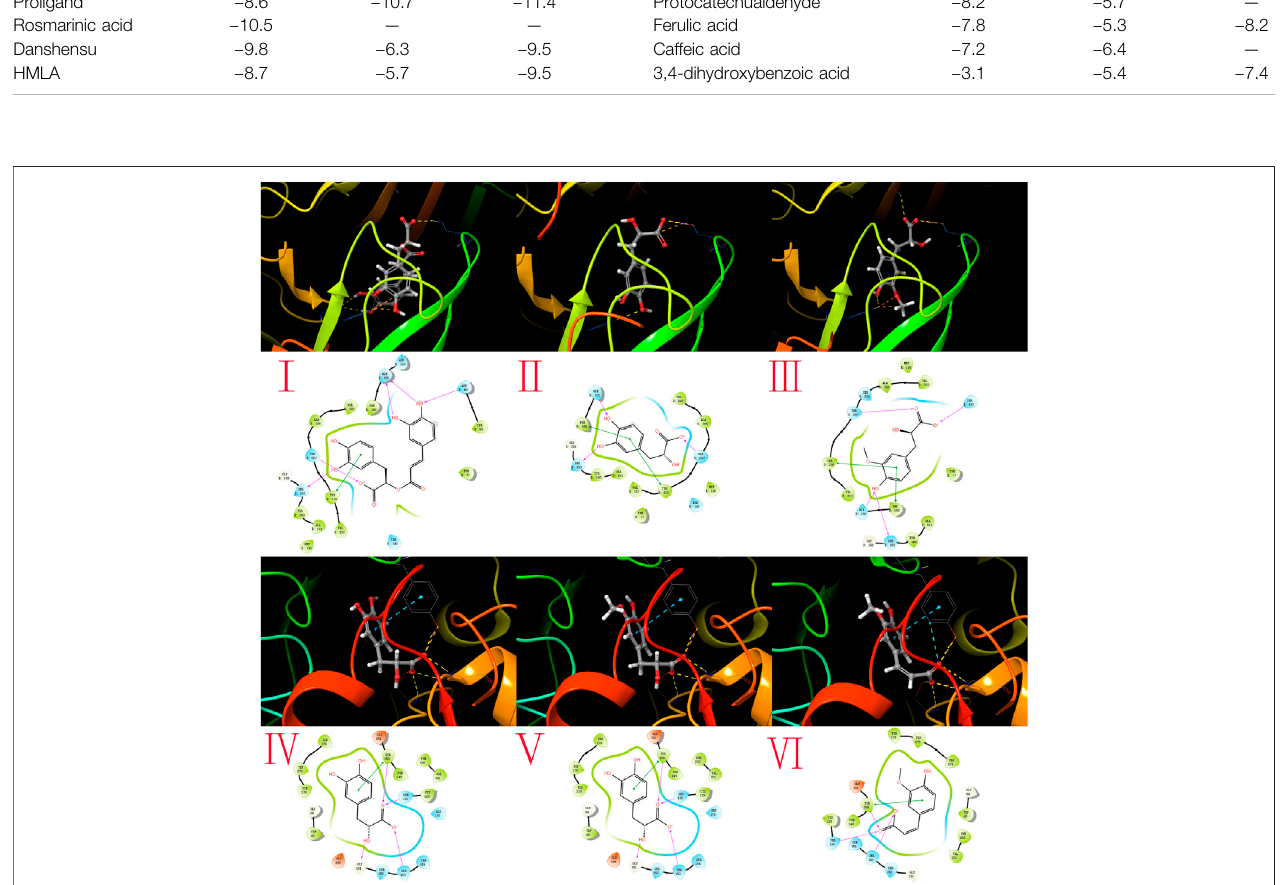
FIGURE6| Molecular docking results.TheactionmodesofpotentialactivecompoundswiththeclassicsedativeandhypnotictargetswerecalculatedbyMaestro 11.8,the3D(upper)and2D(lower) interactiondiagramofGABA A (6D6U), anddopamine D2receptor(4MS4)withrepresentativecompounds areshown. (A) Theaction modeofrosmarinicacidand6D6U; (B) theactionmodeofdanshensuand6D6U; (C) theactionmodeofHMLAand6D6U; (D) theactionmodeofdanshensuand4MS4; (E) the action mode of HMLA and 4MS4; and (F) the action mode of ferulic acid and 4MS4.